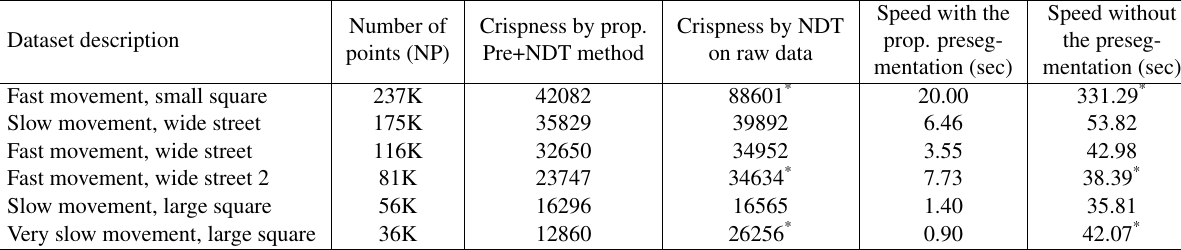
Table 1: Speed and crispness comparison (lower values mean better registration. * denotes failed registration on the full point cloud)